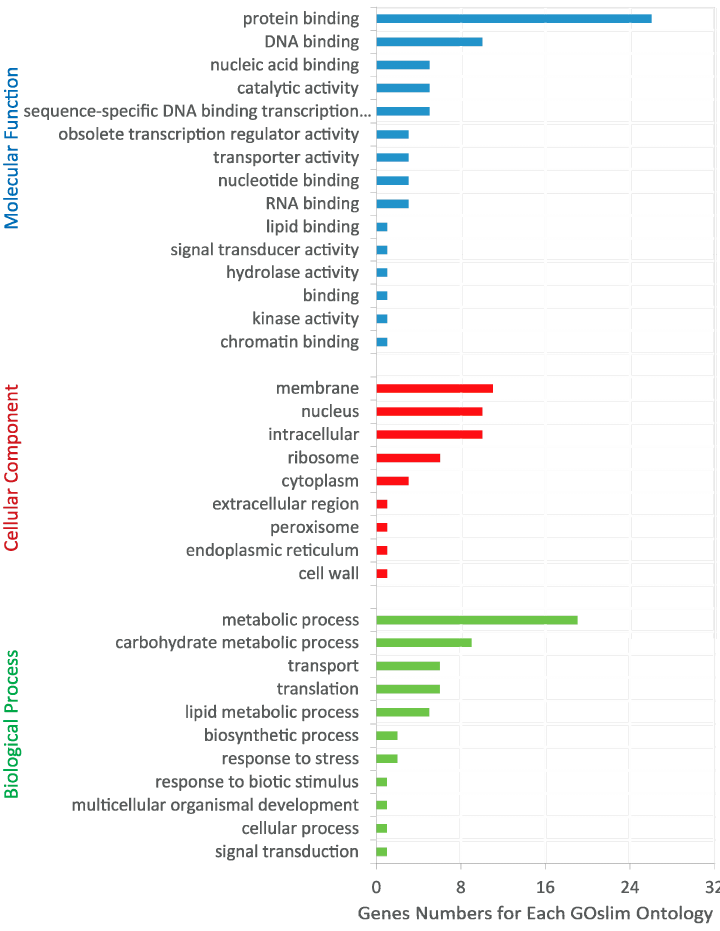
Figure 8. Gene Ontology (GO) Slim classification of DEGs between P. pruinosa and P. euphratica young leaves. DEGs were first annotated with GO terms and then classified by GO Slim analysis. The results are summarized for the three main GO categories: biological process, cellular component, and molecular function.